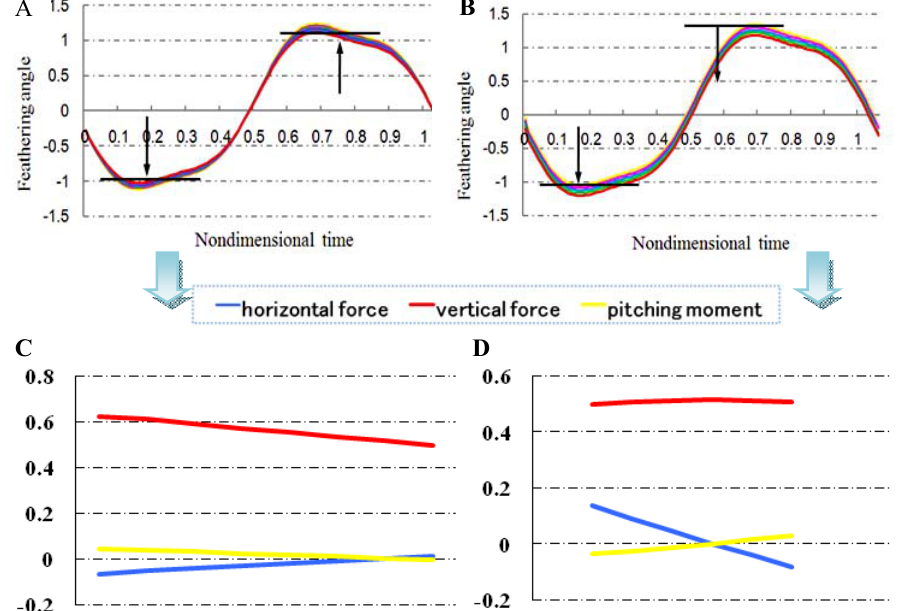
Fig.4 (A) Increase the absolute value of feathering angle (B) Shift the feathering angle downward. (C) The corresponding mean forces and moment when increase the absolute value of feathering angle and (D) shift the feathering angle downward. The horizontal axes of (C) and (D) express the different cases when changing the feathering angle above,